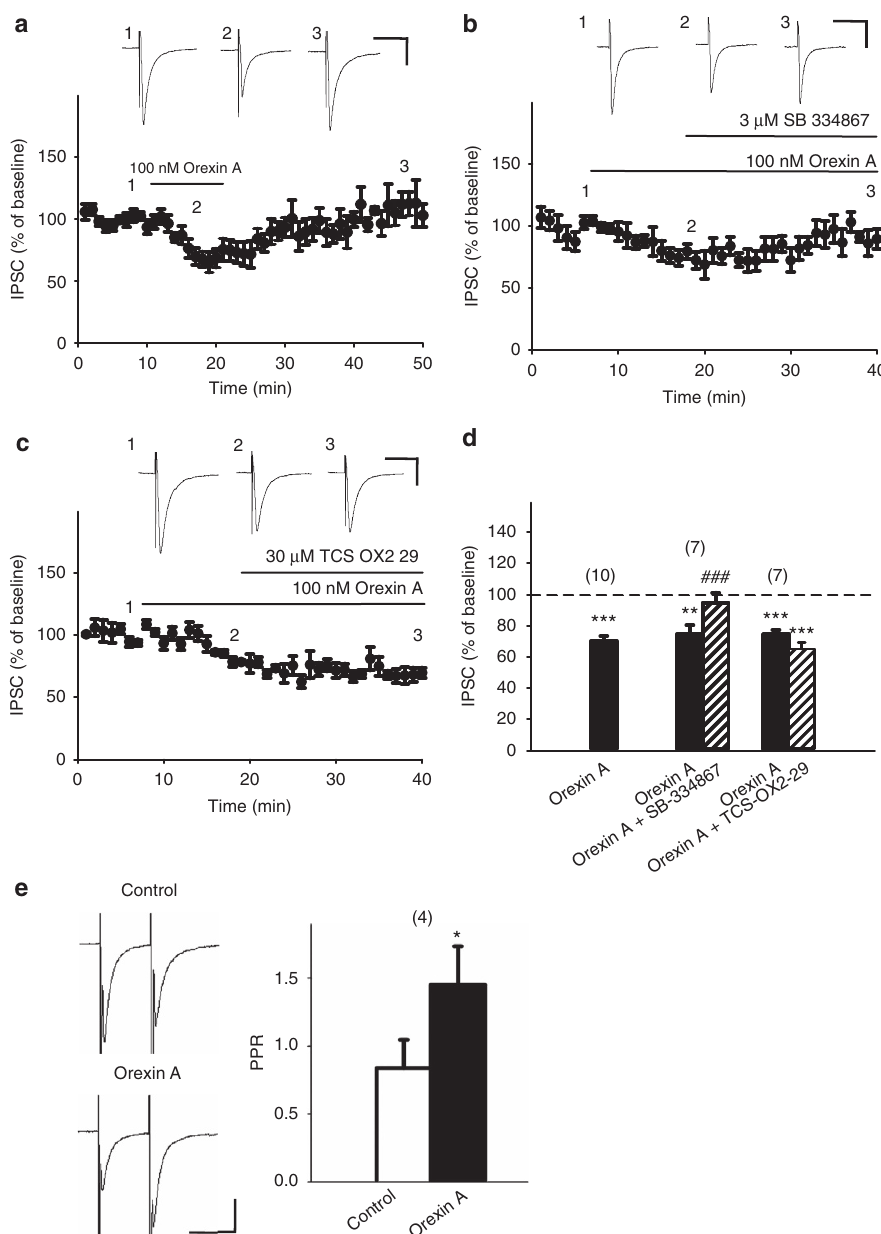
Figure 1 | Orexin A depressed IPSCs in VTA slices through OX1Rs, but not OX2Rs, via a presynaptic mechanism. ( a – c ) Time courses of the effects of orexin A on IPSC amplitude in representative slices ( a ) alone, or in combination ( b ) with SB-334867, an OX1R antagonist, or ( c ) with TCS-OX2-29, an OX2R antagonist. Inward IPSCs evoked at 0.05Hz were recorded at (cid:2) 70mV with a KCl-based internal solution in the presence of 2mM kynurenic acid, and every three IPSCs were averaged. Shown are representative traces taken at the indicated time points. ( d ) Summarized effects of orexin A (100nM) on IPSC amplitude without (black bars) or with 3 m M SB-334867 ( n ¼ 7, P o 0.001 ; t (6) ¼ 6.818) or 30 m M TCS-OX2-29 ( n ¼ 7, P ¼ 0.0814; t (6) ¼ 2.091). Ten IPSCs at 10–15min after drug application, when the response had stabilized, were averaged. The averaged amplitude of 10 IPSCs before drug treatment in each neuron was taken as 100% baseline. Data are presented as mean ± s.e.m. The number of recorded neurons is denoted above each bar. Grouped bars represent the data from the same group with different treatments conducted sequentially. ** P o 0.01, *** P o 0.001 versus 100% (one sample t -test); ### P o 0.001 versus orexin A alone: n ¼ 10 (paired t -test). ( e ) The effect of orexin A (100nM) on the PPR of IPSCs. Paired IPSCs were evoked by 50ms-separated paired pulses every 20s. Left panel: a representative paired IPSCs recorded in a neuron before and 10min after orexin A treatment. Scale bars, 50ms and 200pA. Right panel: average PPR of IPSCs in four neurons recorded before (control) and after orexin A treatment. ( n ¼ 4, P ¼ 0.026; t (3) ¼ 4.089). * P o 0.05 versus control (paired t -test). Data are expressed as mean ± s.e.m.